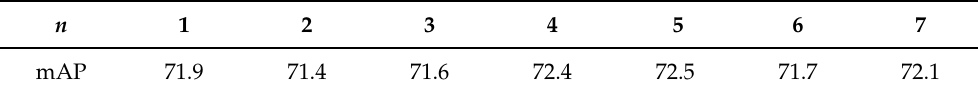
Table 1. Effect of the number of bins in PCR.